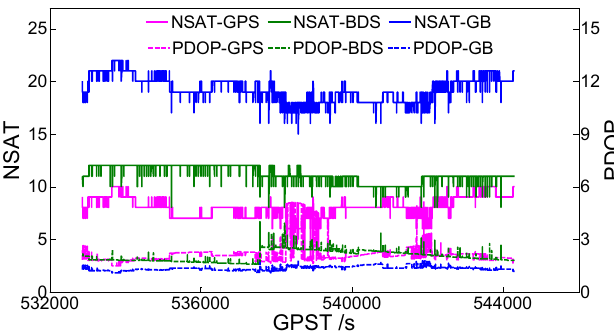
Figure 5. Number of satellites (NSATs) and the PDOP value. GB denotes GPS + BDS. Table 4. Positioning precision statistics.